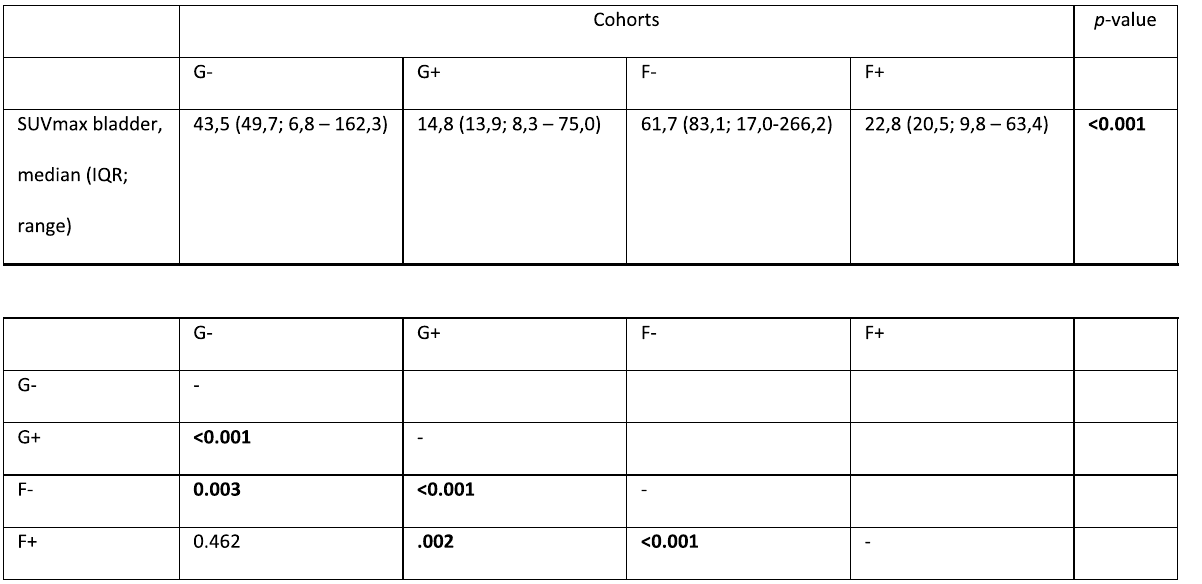
Table 2 A. Boxplots of maximum standardized uptake values of activity in the urinary bladder (SUVmax bladder) in cohorts G‑, G and F . B. Overall comparison between cohorts G‑, G +